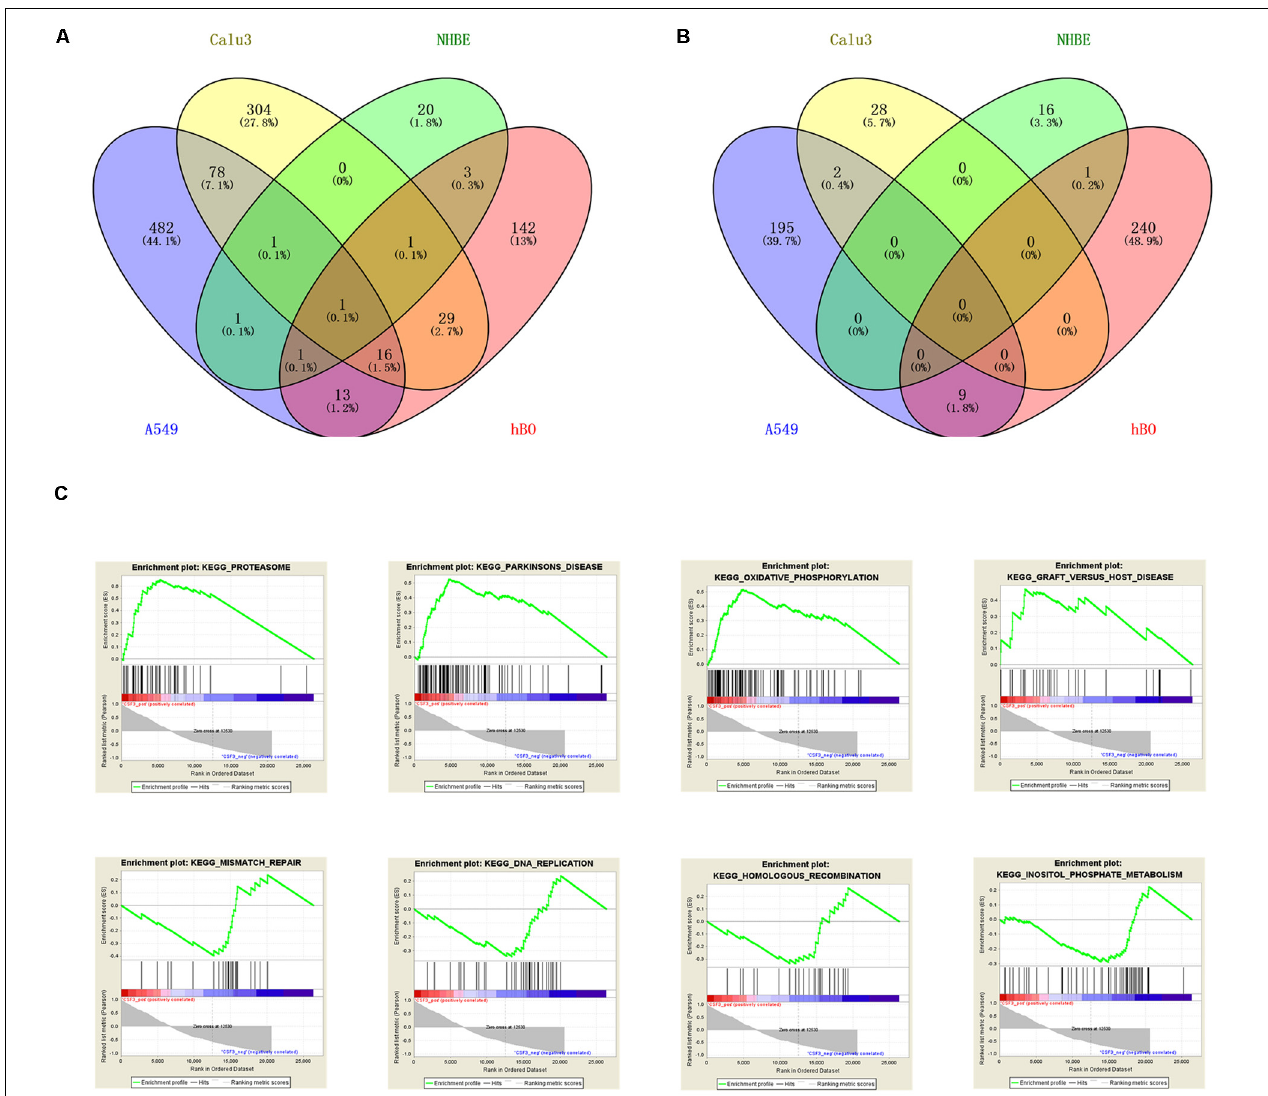
FIGURE 3 | Identification and analysis of overlapping DEGs. VENNY software identified the upregulated DEGs (A) and downregulated DEGs (B) of the four sets of samples in GSE150819 and GSE147507. (C) The overlapping gene CSF3 was analyzed by GSEA. There were four positive regulatory pathways of CSF3, which were proteasome, Parkinson’s disease, oxidative phosphorylation, and Graft vs. host disease. The following were four negative regulatory pathways of CSF3: mismatch repair, DNA replication, homologous recombination, and inositol phosphate